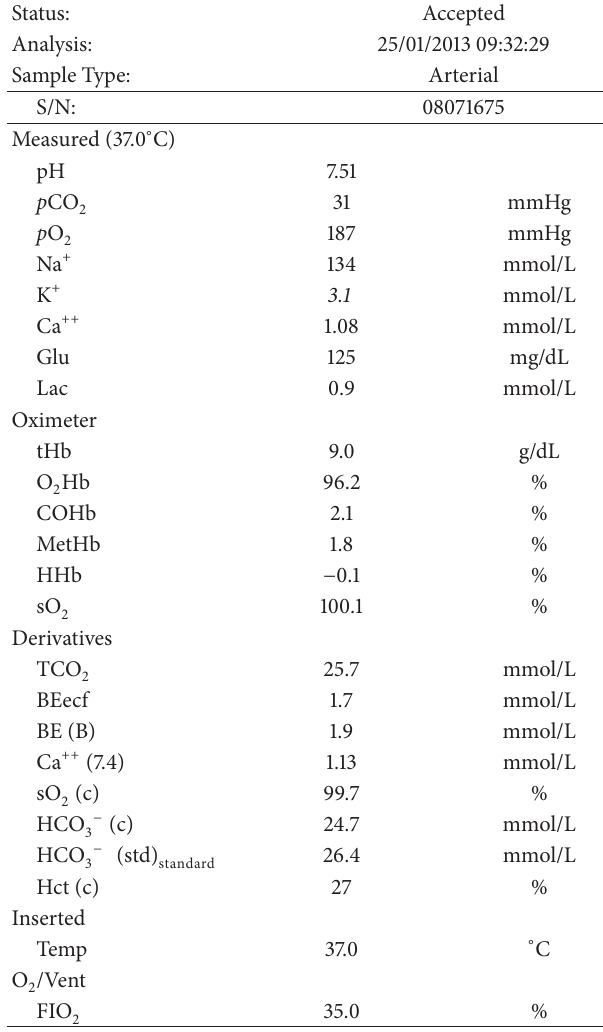
Table 1: Hemogasanalysis 30 minutes after the start of the